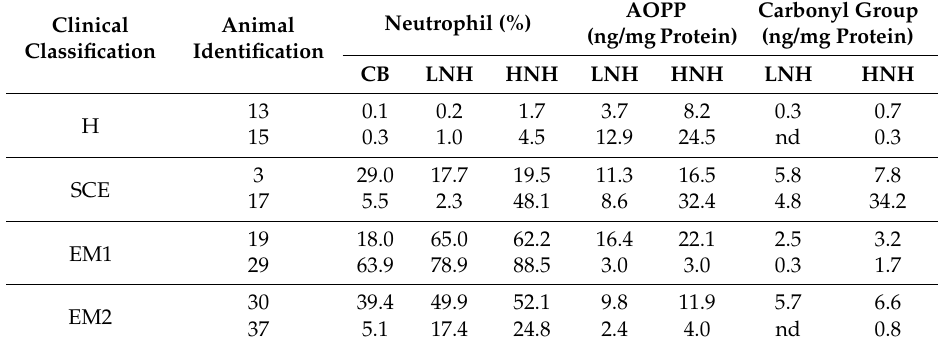
Table 1. Characteristics of the animals selected to investigate the oxidation of the proteins present in the uterine lavage fluids by SDS-PAGE and Western blot analysis to detect carbonylated proteins and dityrosine